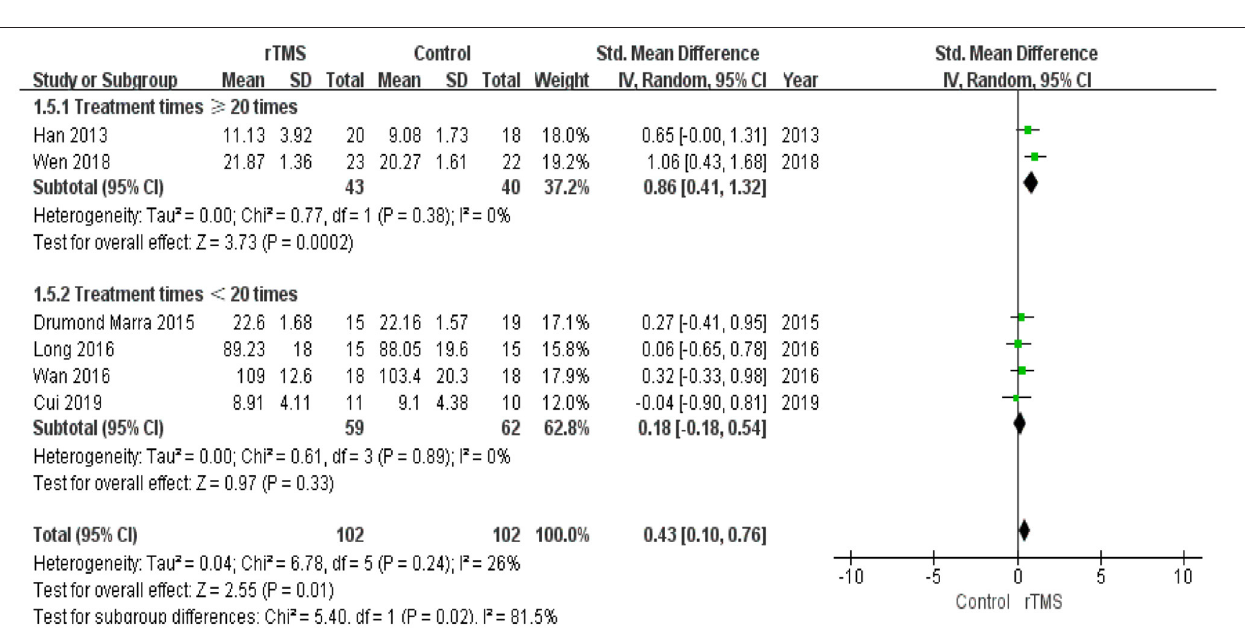
FIGURE 10 | Meta-analysis forest plot of subgroup analysis showing memory of repetitive transcranial magnetic stimulation group vs. control group in the treatment of mild cognitive impairment: treatment times ≥ 20 times vs. treatment times < 20